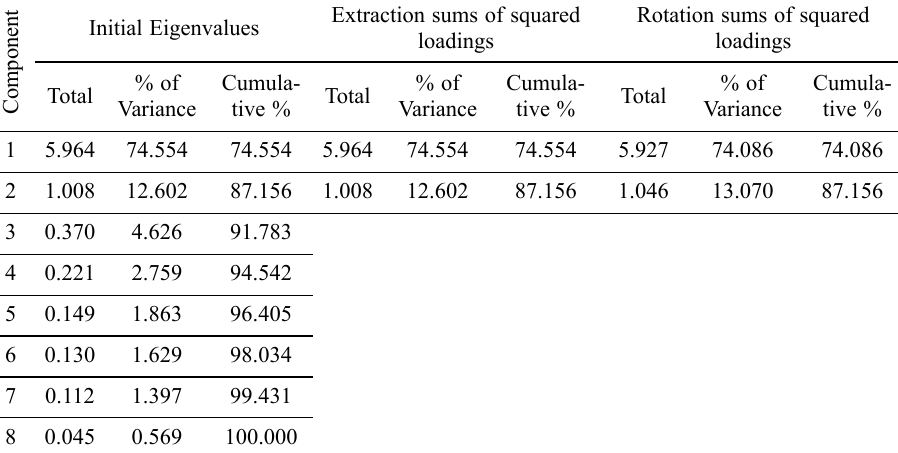
Table 3. Results of variance